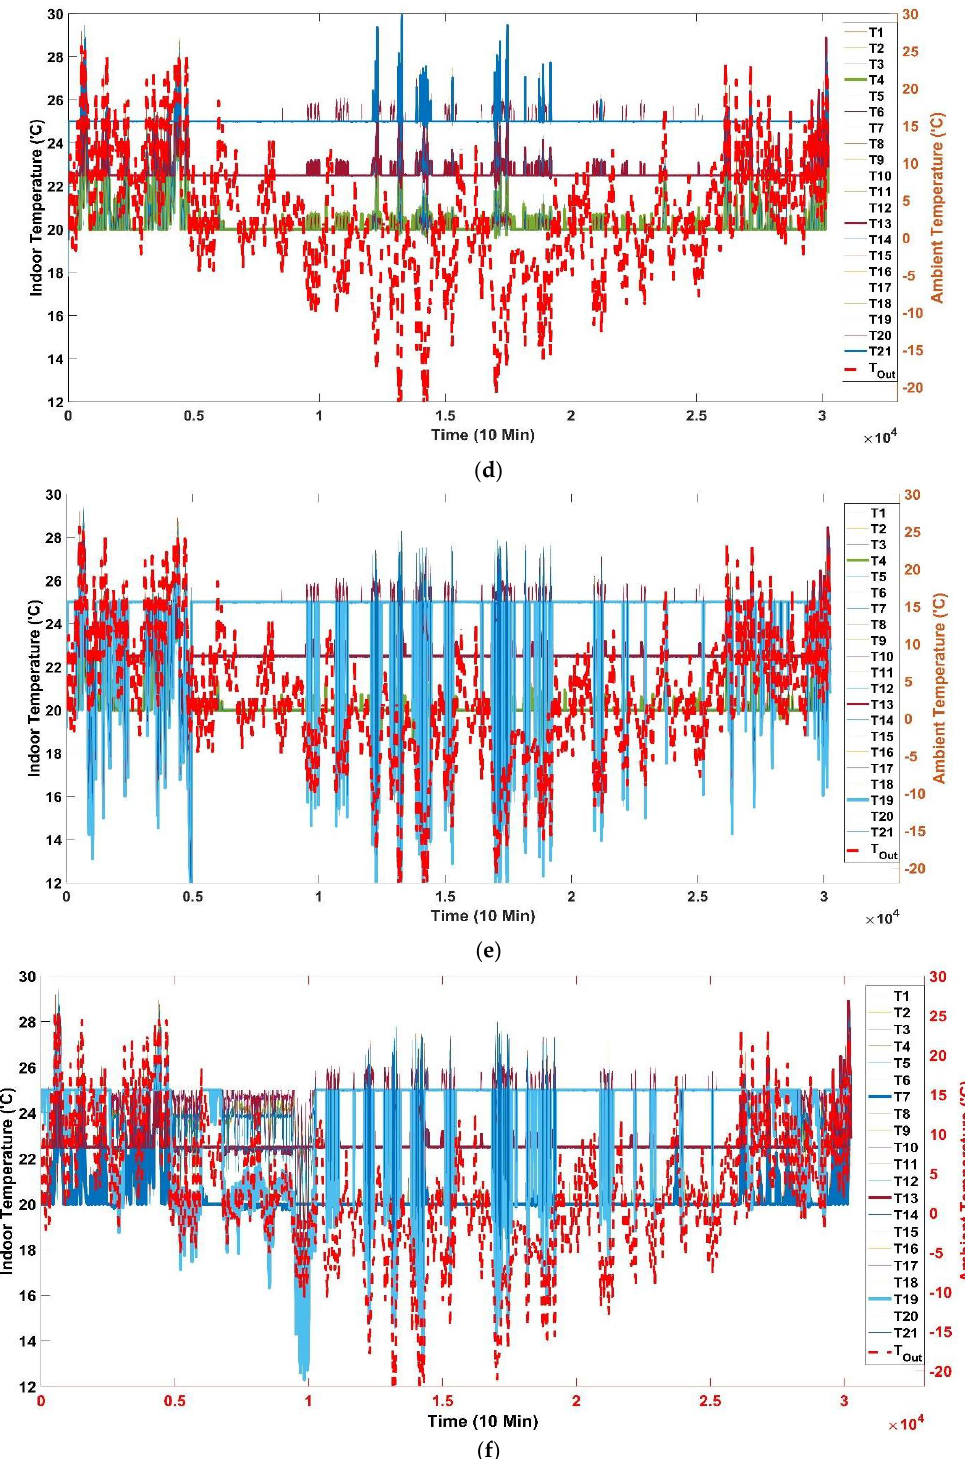
Figure 10. The building zones temperatures by applying controllers to the steam heating system. (T1 to T21 represent building zones temperatures) ( a ) MPC-GA, ( b ) FLC, ( c ) OFSMC, ( d ) On/Off, ( e ) PID-GA, and ( f ) Fuzzy-PID. Overall, regulating indoor temperatures by various controllers indicates that artificial intelligent controllers, including MPC-GA, FLC, and OFSMC, provide occupancy comfort temperatures better than traditional